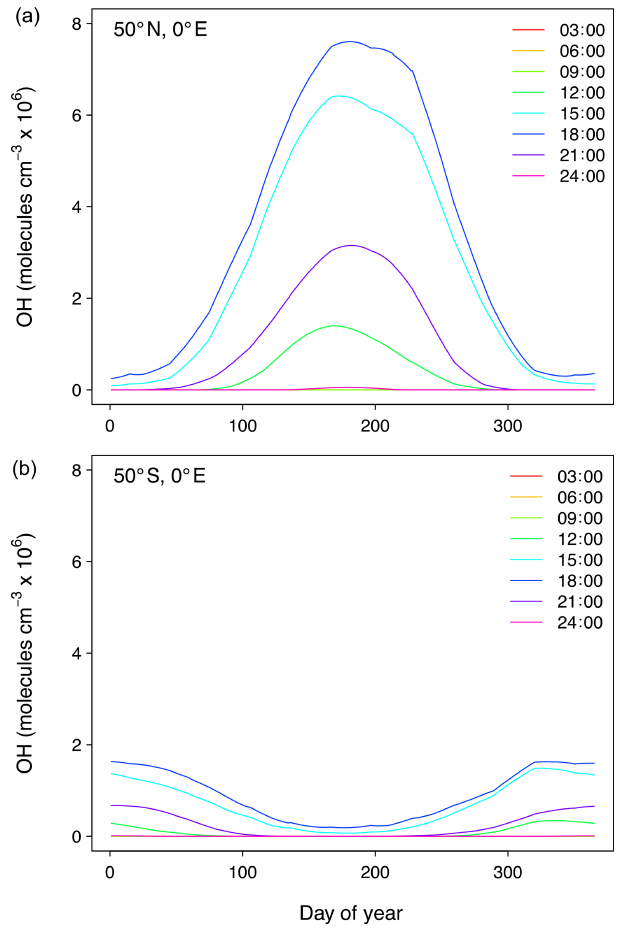
Figure 5. Annual and daily OH concentration variation as obtained with the simple parameterization based on photolysis rates of ozone for two locations, one in the Northern Hemisphere (a) and one in the Southern Hemisphere (b) . Line labels correspond to the time of day.